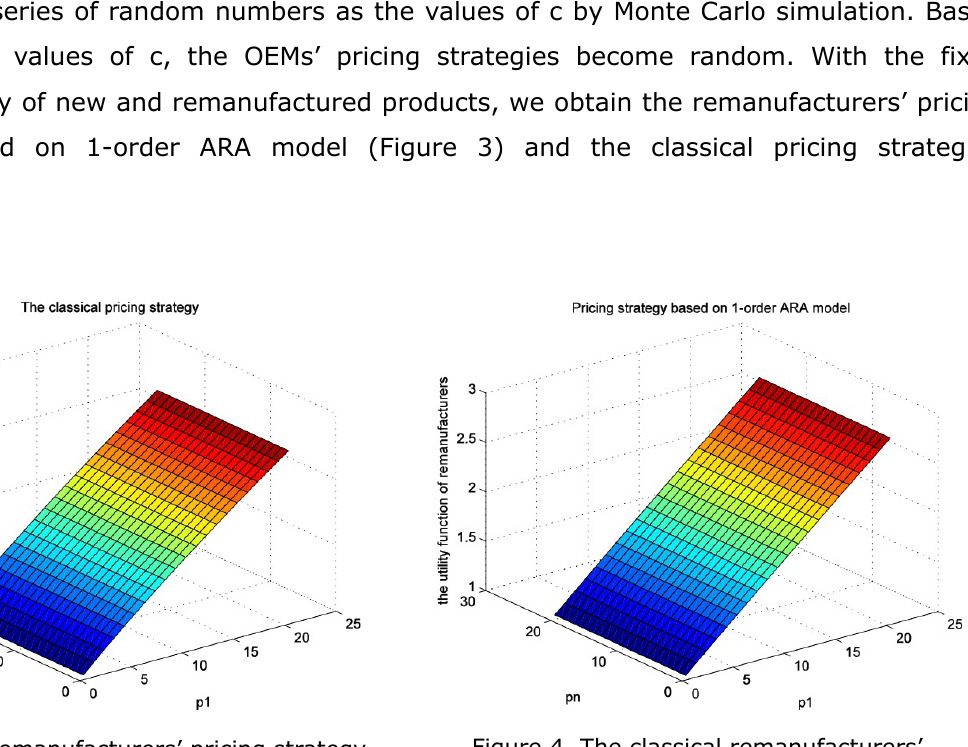
Figure 3. The remanufacturers’ pricing strategy based on 1-order ARA model